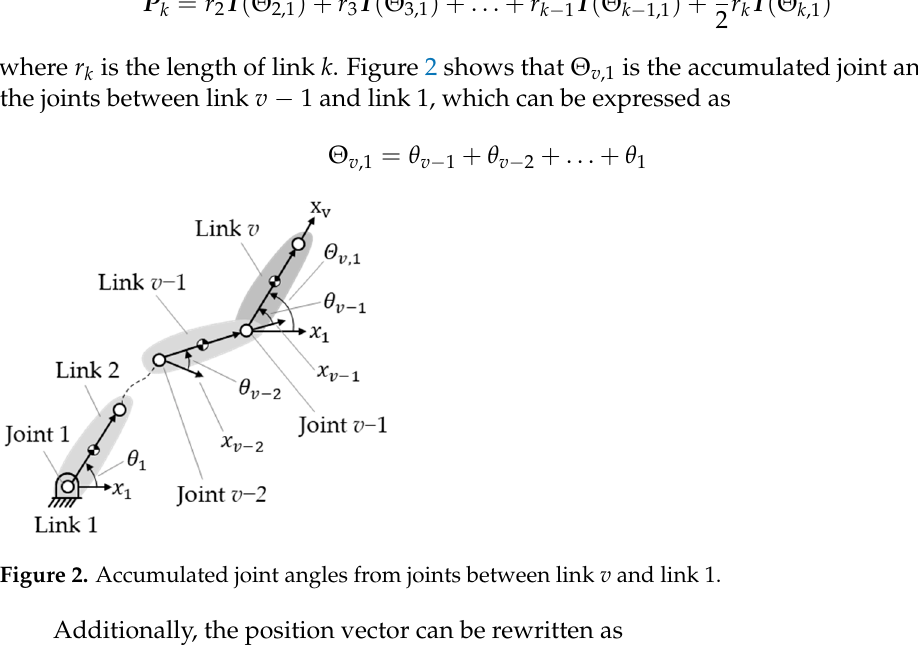
Figure 1. A typical joint u in an n -link manipulator.